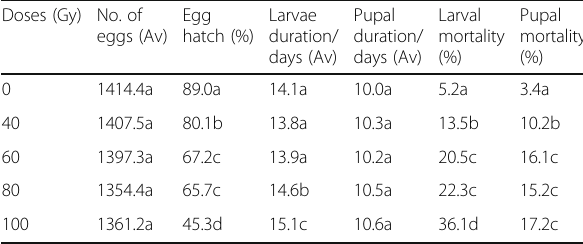
Table 2 Effect of gamma irradiation on the reproductive biology of Spodoptera littoralis irradiated as full-grown male